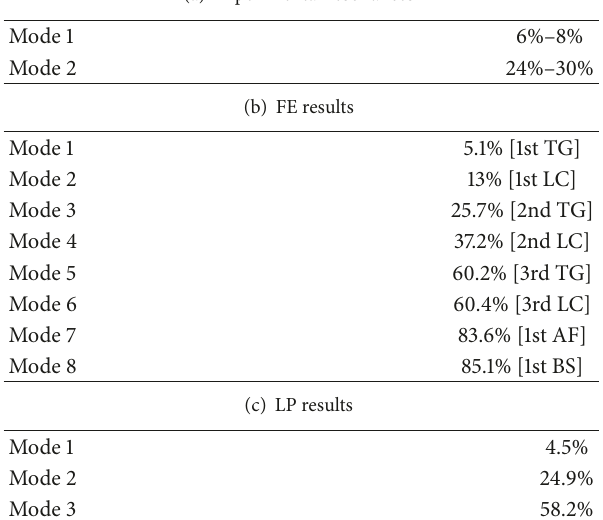
Table 8: Comparison of resonance frequencies in (a) experimental measurements, (b) FE model, and (c) LP model for the 70 Sh rubber element configuration with reference to 𝑓 max